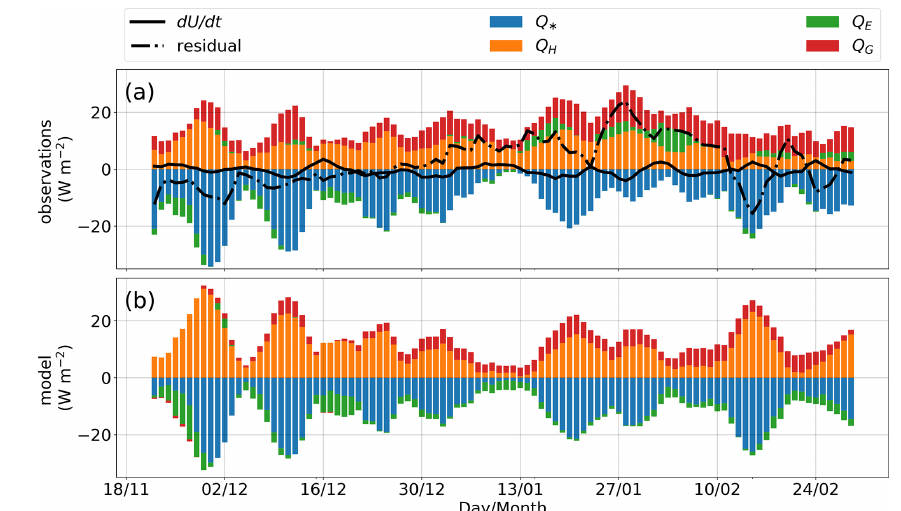
Figure 9. (a) Observed and (b) simulated daily snowpack energy budget terms comprising sensible ( Q H ) and latent heat fluxes ( Q E ), net radiation ( Q ∗ ), ground heat flux ( Q G ), and the change in the internal energy of the snowpack d U/ d t , during the first half of winter 2018/19. The modeled ground heat flux also includes the heat storage change d U/ d t in the snowpack. The modeled snow enthalpy change is not shown because it includes changes due to precipitation and is therefore not comparable to observations.